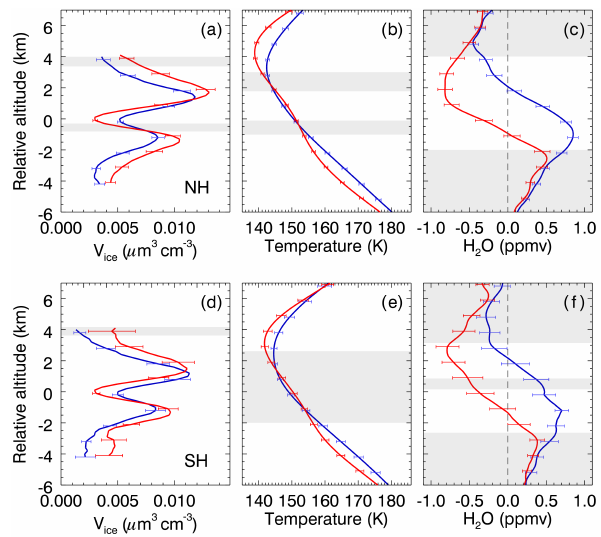
Figure 6. Vertical structures of the V ice (a, d) , background tem- perature (b, e) , and water vapour residual (c, f) for the NH (upper panel) and SH (lower panel) respectively. Red profiles are averaged by the 20% events of all double-layer PMCs with highest modu- lations, while blue profiles are averaged by the 20% events of all double-layer PMCs with lowest modulations. Before the averaging, all profiles are aligned to their troughs. Error bars show the standard deviation of the mean. The grey translucent rectangular areas show the regions where the significances derived by t tests are larger than